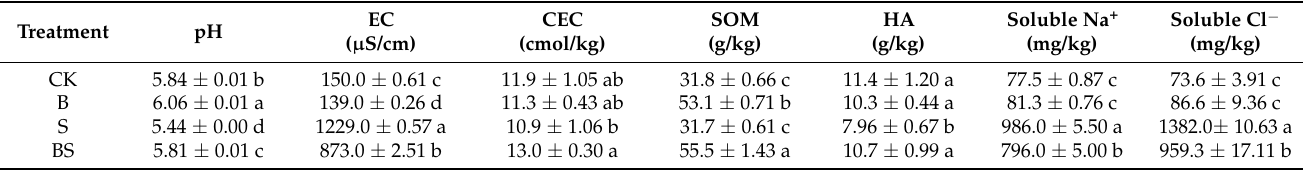
Table 1. The physical and chemical properties of soils after rice